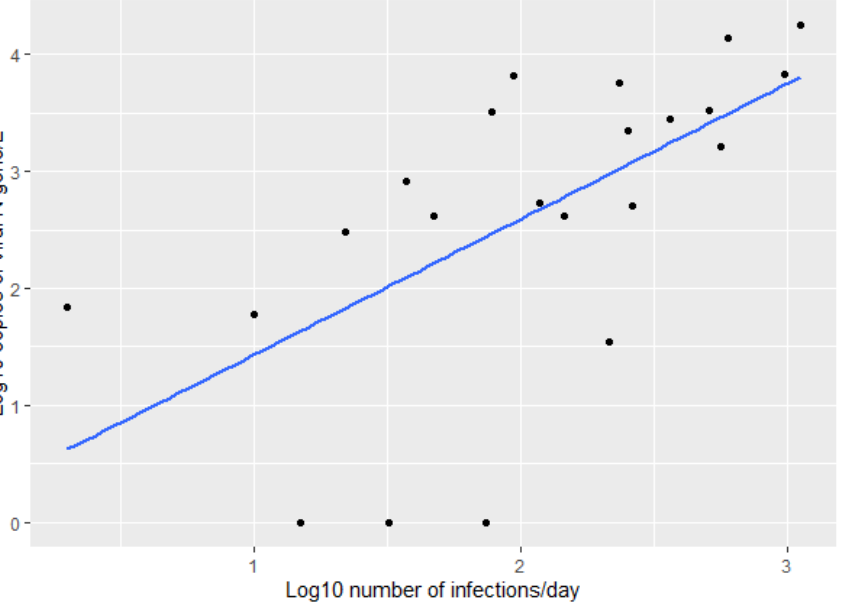
Figure 3. Correlation between the log10 transformed number of infections three days from the sampling day and the log10 transformed amount of virus detected in WWTP influent (Pearson correlation = 0.621).